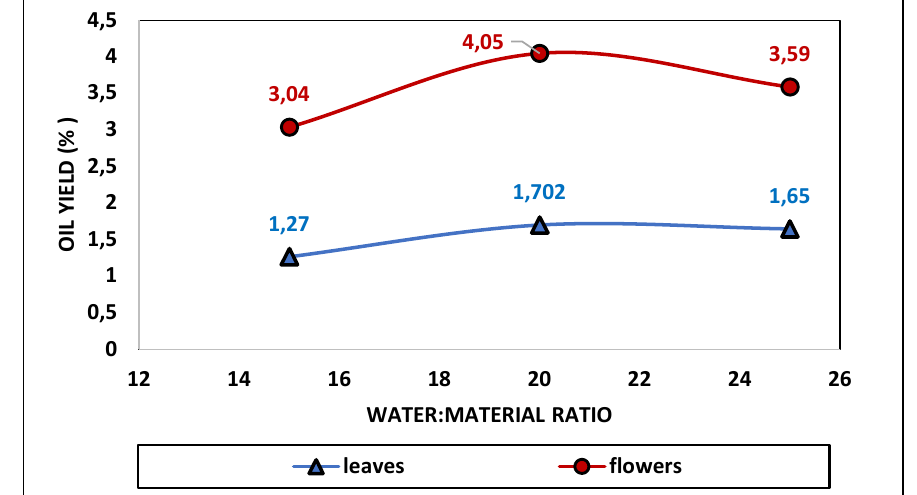
Figure 3. The effect of the water and material ratio on M. pulegium essential oil extraction operating conditions (temperature 80 °C, extraction time 60 min and drying 7 days)